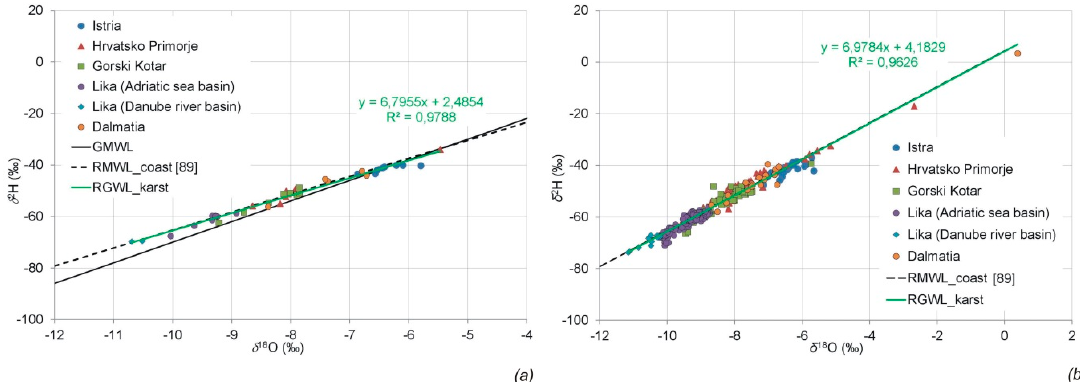
Figure 2. The regional meteoric water line of the coastal part of Croatia (RMWL_coast) and the stable isotope composition of the spring water in the Dinaric karst in Croatia: ( a ) the mean values of the stable isotopes and ( b ) the single values of the stable isotopes.